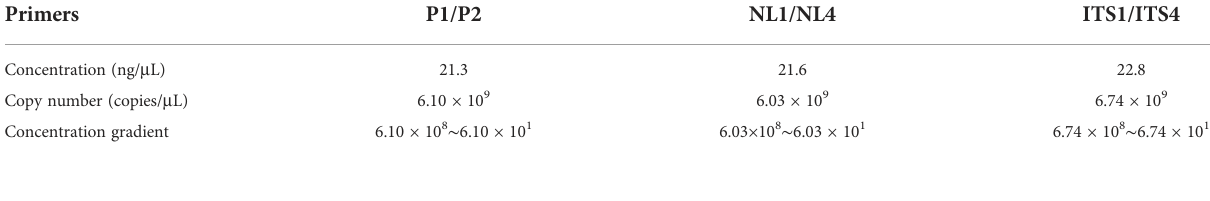
TABLE 4 Plasmid standard concentration and copy number of ampli fi cation products with different primers. Primers